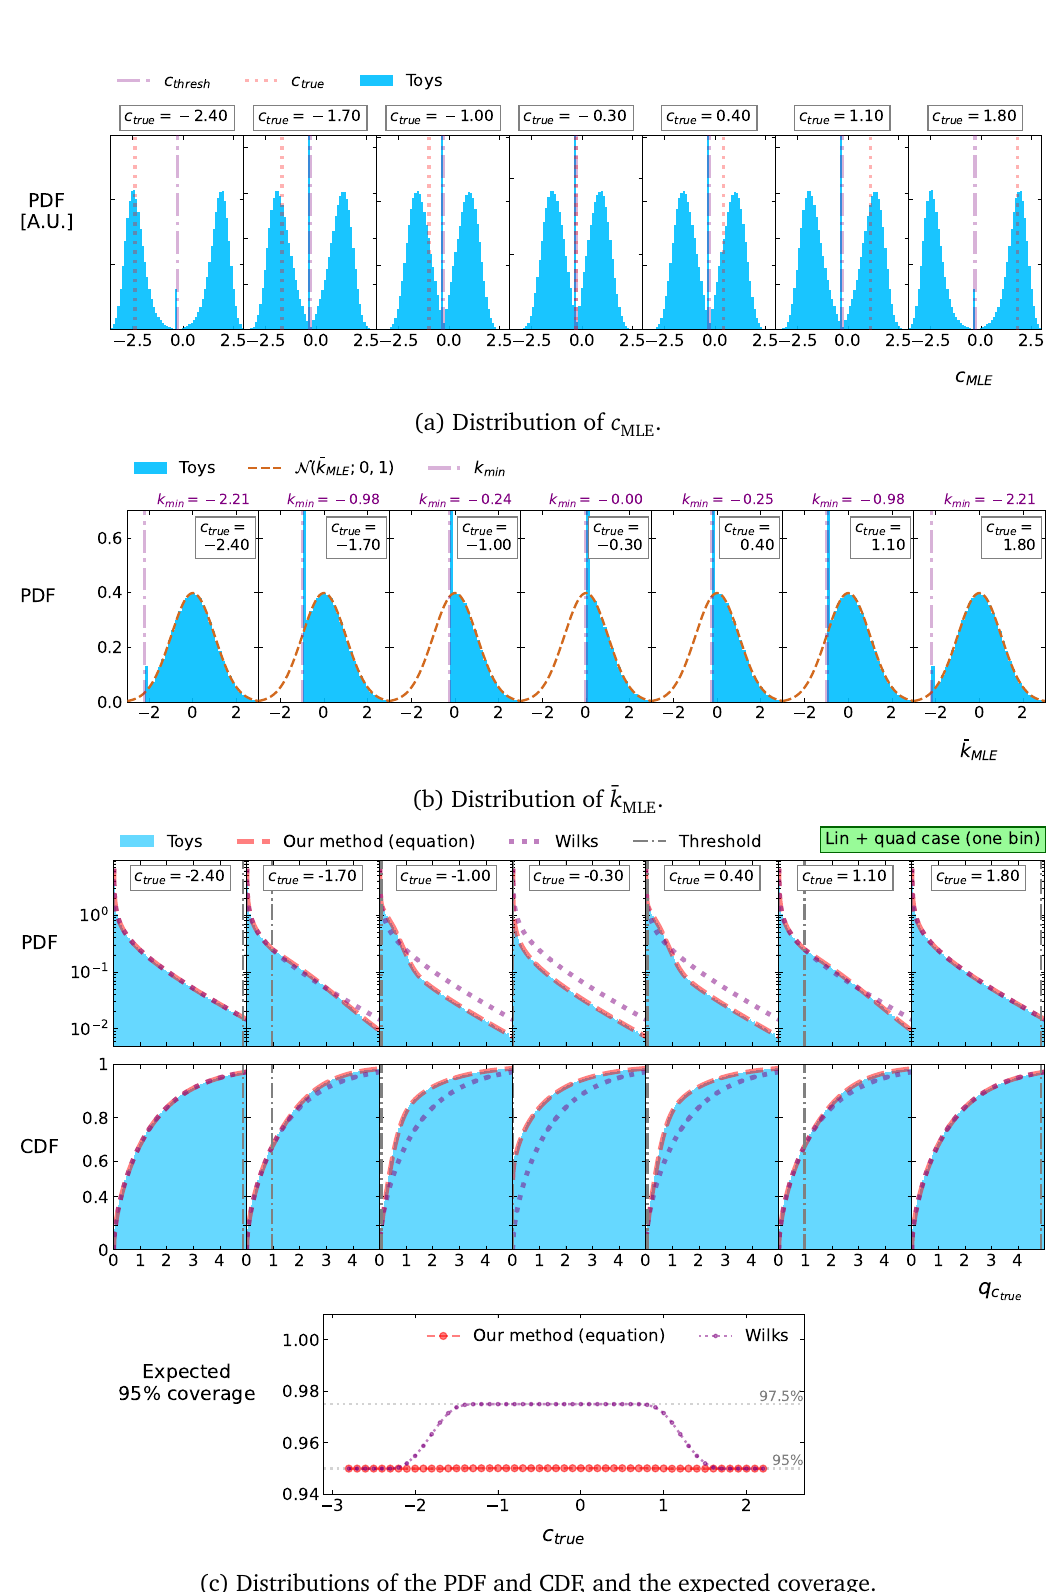
Figure 10: Analysis of a one-bin “linear plus quadratic” example with ¯ l = 0.3 and ¯ n =